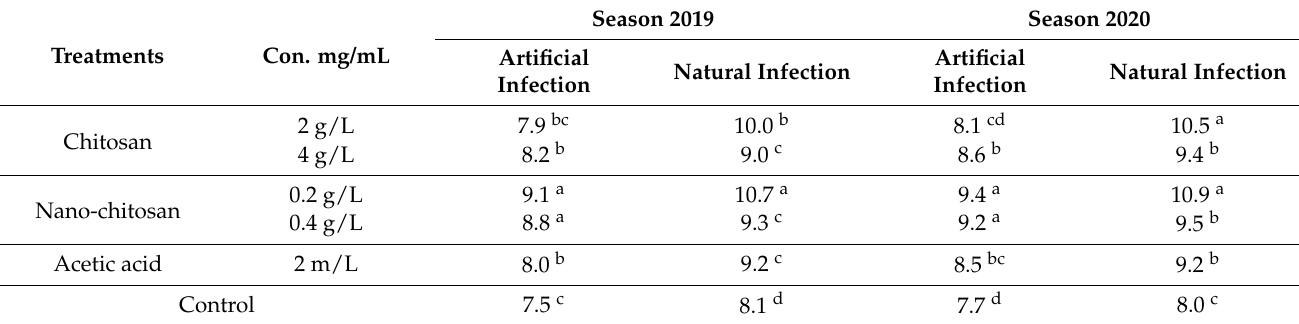
Table 4. Effect of chitosan and its nanoform on firmness (lb/in2) of Anna apples after 45 days of cold storage at 4 ± 1 ◦ C during seasons 2019 and